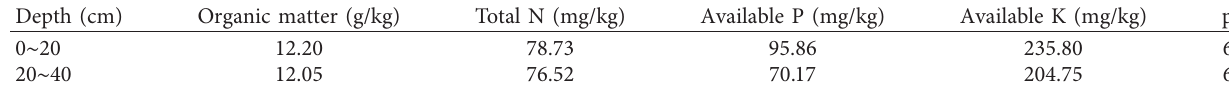
Table 1: Basic properties of the tested